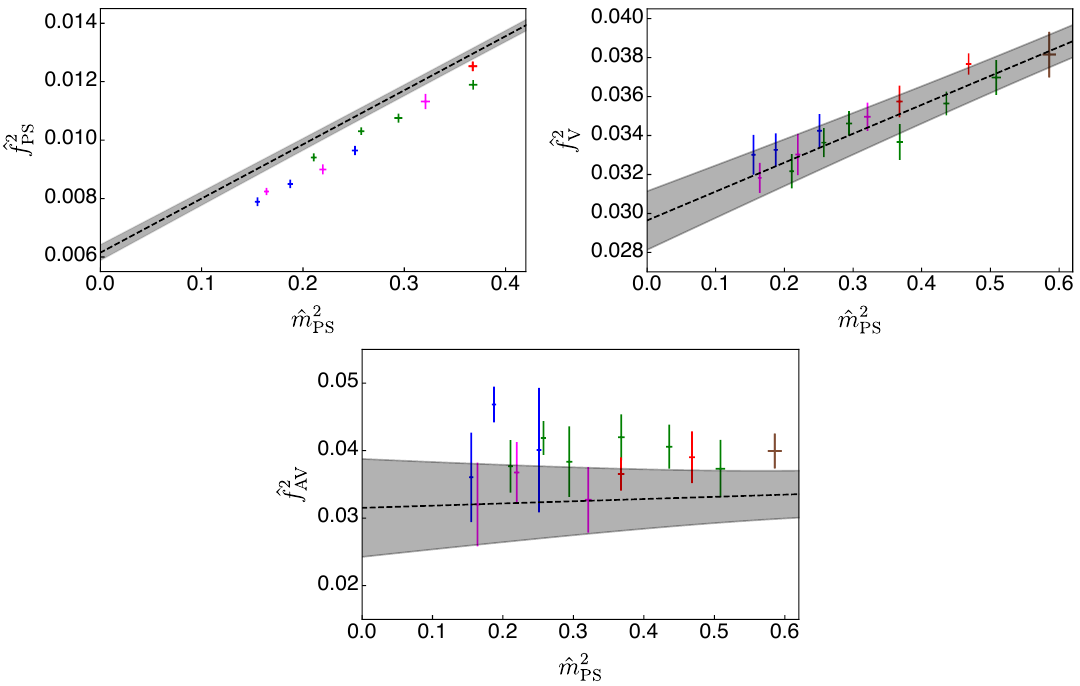
Figure 10. Top to bottom, left to right: decay constants squared of the pseudoscalar (PS), vector (V), and axial-vector (AV) mesons, as a function of the pseudoscalar mass squared ^ m 2 colours denote di(cid:11)erent lattice couplings: (cid:12) = 6 : 9 (blue), 7 : 05 (purple), 7 : 2 (green), 7 : 4 (red), and 7 : 5 (brown). The grey bands (the width of which indicates the statistical error) show the results of the continuum and massless extrapolations after subtracting the discretisation artefact, as discussed in the